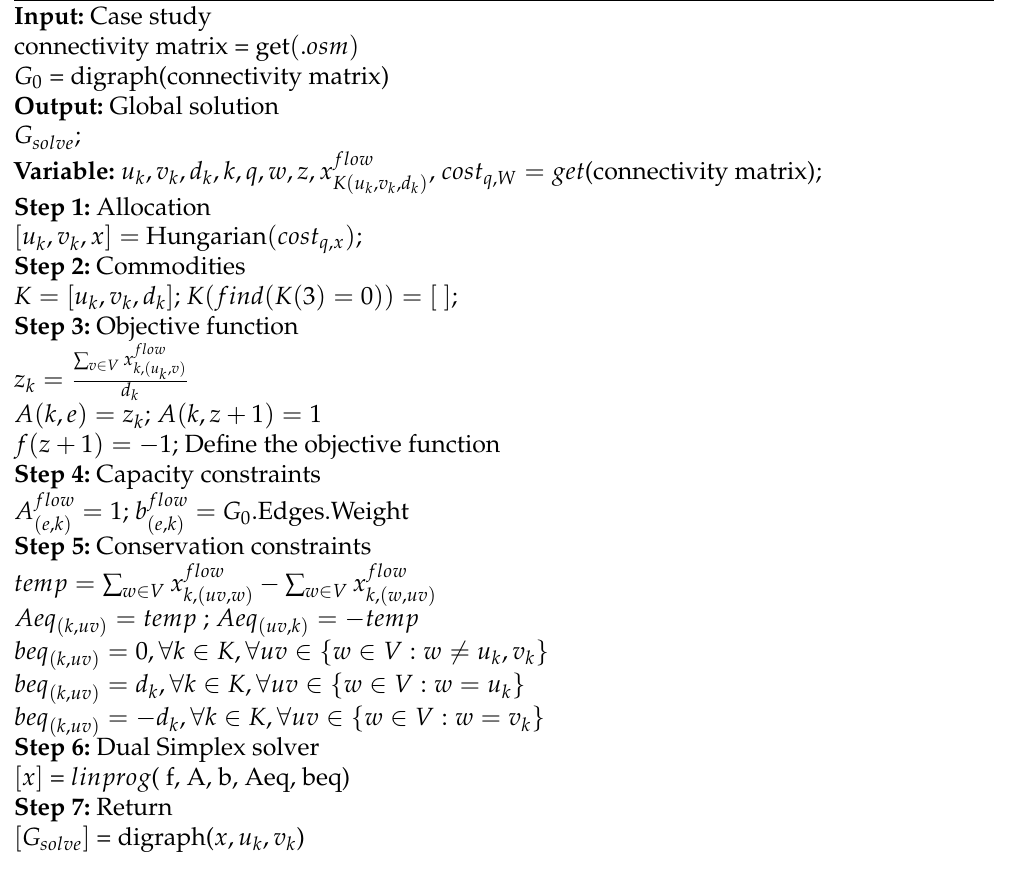
Algorithm 1 Optimal Sizing for Charging Stations Infrastructure